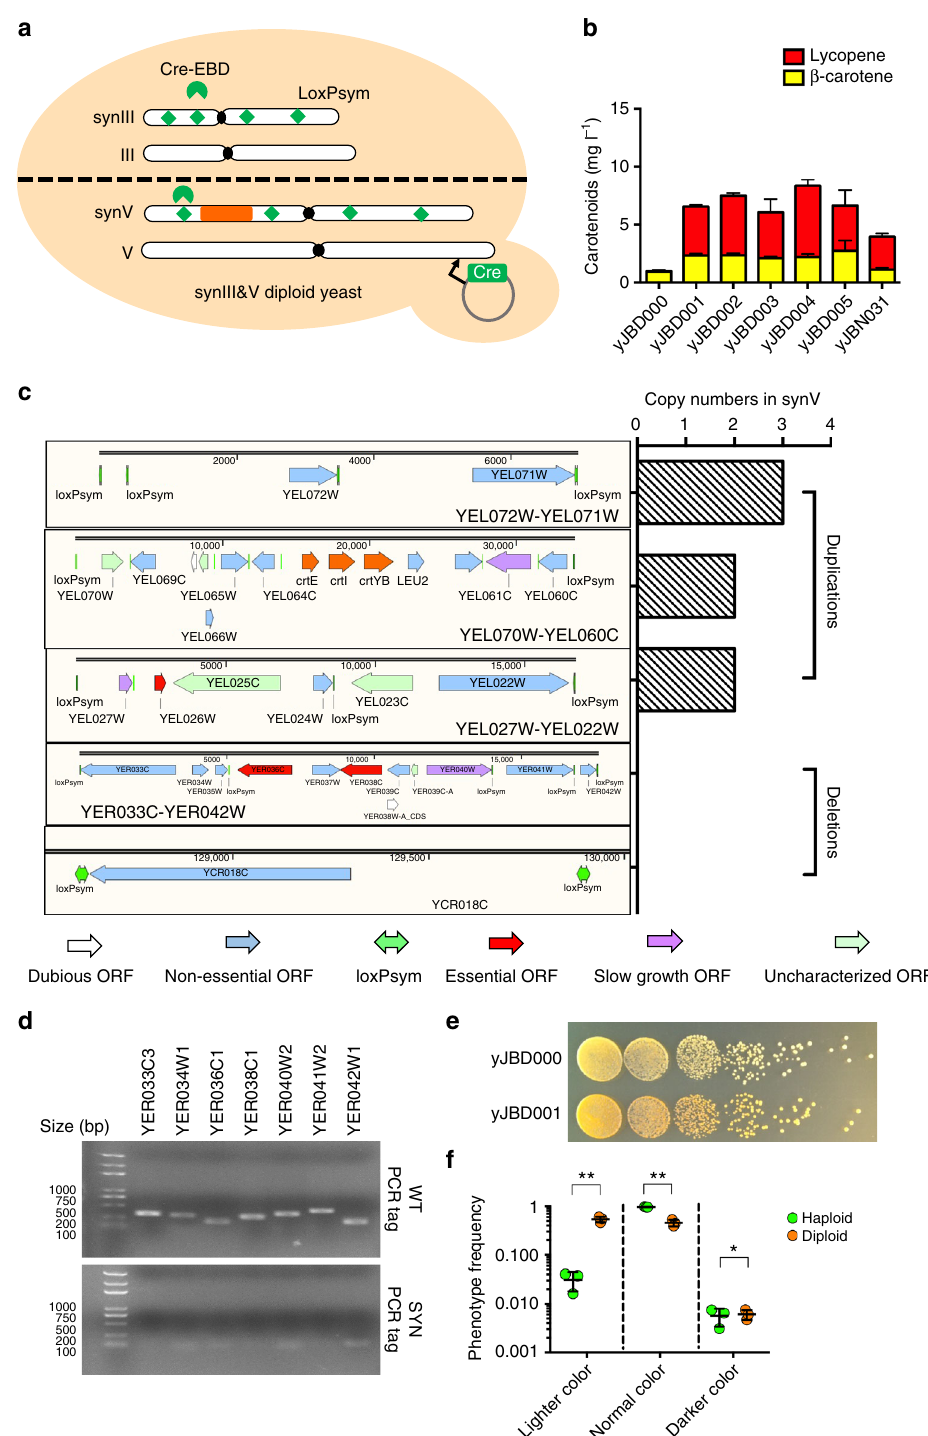
Fig. 3 SCRaMbLEing synIII&V diploid yeast. a The synIII&V diploid yeast cells containing the pCRE4 were induced to SCRaMbLE. The synIII&V diploid yeast were generated by mating synV haploid yeast ( MAT a ) and synIII yeast ( MAT α ). b Quanti fi cation of extracted carotenoids from fermentation culture of strains. c Sequence analysis of yJBD001. Three duplications (YEL072W-YEL071W, YEL070W-YEL060C, and YEL027W-YEL022W) and two deletions (YER033C-YER042W and YCR018C) were observed in the diploid yeast yJBD001. YEL070W-YEL060C contains the carotenoid pathway. d YER033C- YEL042W PCRTag analysis. The absence of synV YER033C-YEL042W and the presence of native wtV YER033C-YEL042W was veri fi ed by the ampli fi cation of synthetic PCRTags (SYN) compared with that of wild-type PCRTags (WT). e Fitness assays of JSD3 strains compared with synIII&V diploid yeast. f Phenotype of diploid SCRaMbLE compared with that of haploid. The lighter color indicates SCRaMbLEd cells with a negative phenotype, including white colonies generated by deletion of the chromosome fragment containing the carotenoid pathway. The normal color indicates synthetic chromosomes with no rearrangement or no relevant rearrangement. The darker color indicates SCRaMbLEd cells with a positive phenotype. Bars are the mean of three biological replicates and error bars are the SD. (Student ’ s t -test; * P < 0.05, ** P <